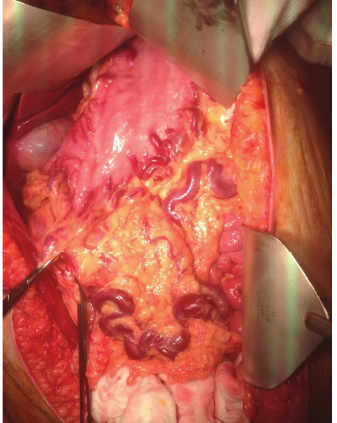
Figure 3: Laparotomy: extensive gastric